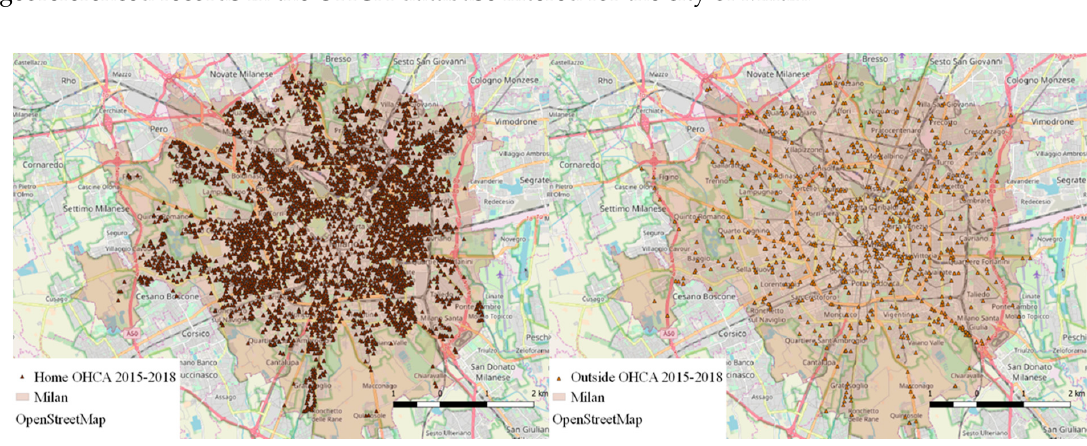
Figure 1. Distribution of georeferenced Out-Of-Hospital Cardiac Arrests (OHCAs), over the territory of the city of Milan from 2015 to 2018, that occurred at residential location (left panel) and outside of residential locations (right panel).